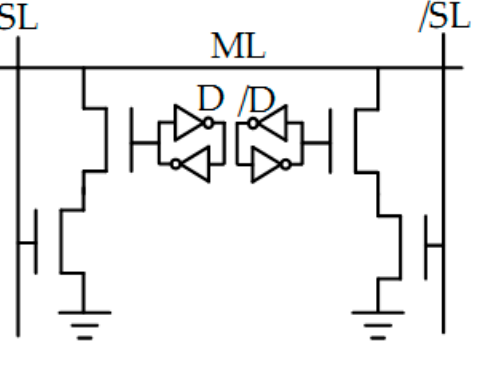
Figure 2. TCAM cell [24].